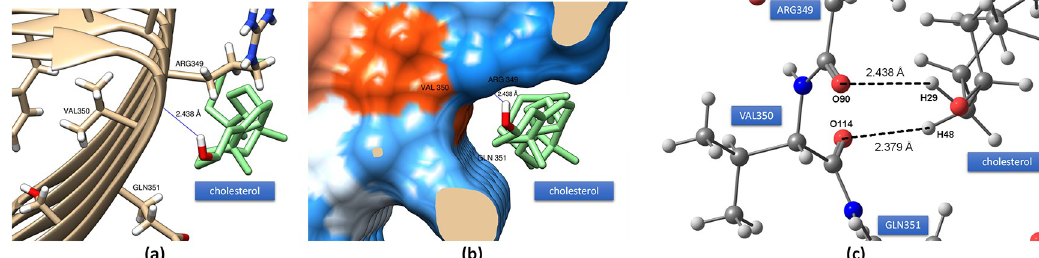
Fig 3. (a) The docking conformation of 3-alpha-cholesterol on PHF-Tau showing the H-bond formation between the PHF-Tau backbone and OH group of the ligand. (b) Electrostatic surface potential model on the docking site of 3-alpha-cholesterol on PHF-Tau which shows the hydrophobicity of the binding site (blue regions are hydrophilic and red orange regions are hydrophobic). (c) H-bonds obtained in NBO